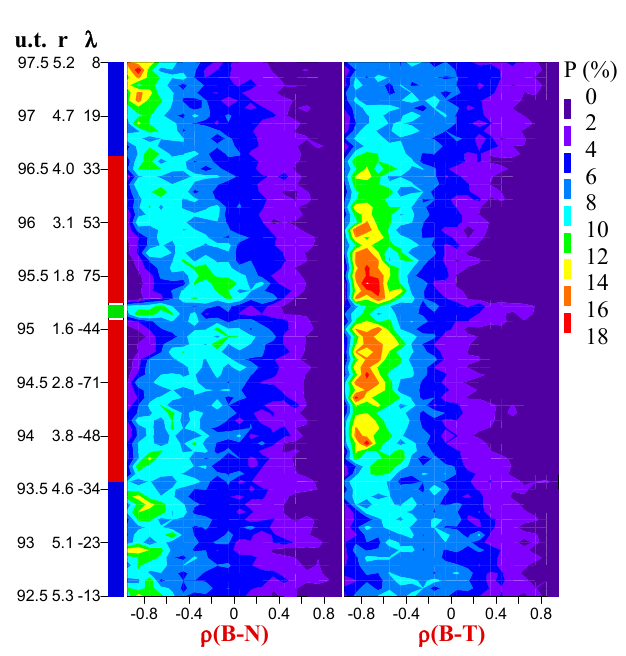
Figure 76: Solar rotation histograms of B-N and B-T in the same format of Figure 75. Image reproduced by permission from Bavassano et al. (2004), copyright EGU.